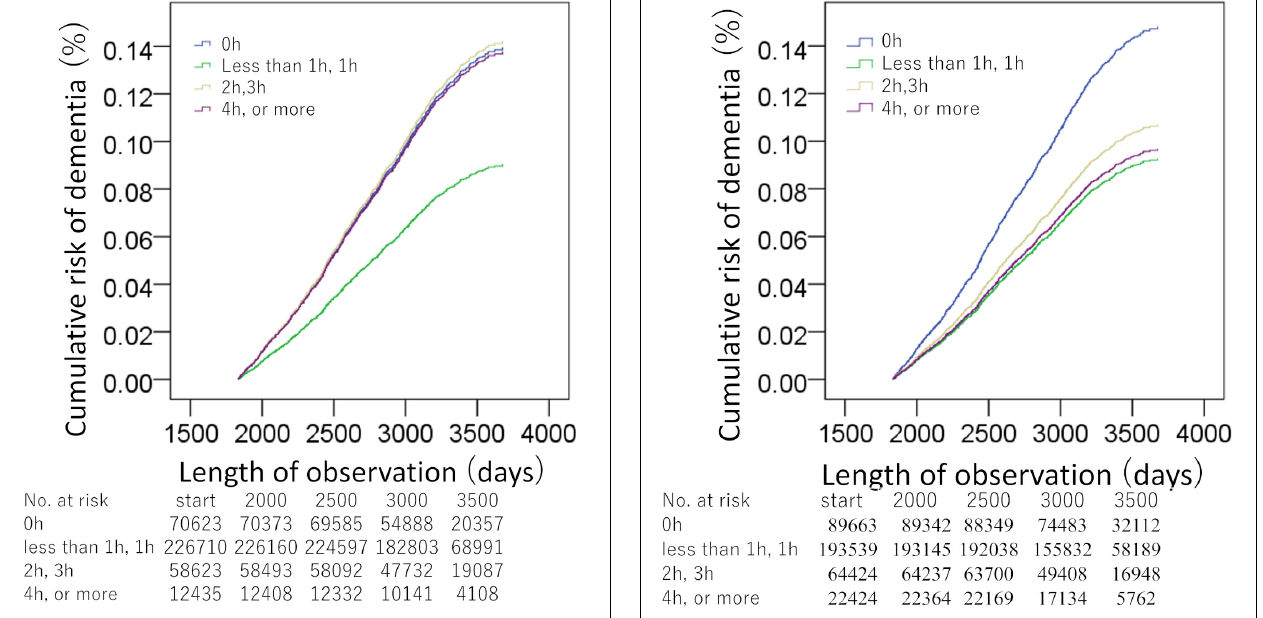
FIGURE 3 | Standardized risks of incident dementia over time according to the daily non-occupational computer use duration. Cox proportional hazards models were adjusted for potential confounding variables. There were significant differences between the group of no non-occupational computer use time ( x = 0 h) and the other